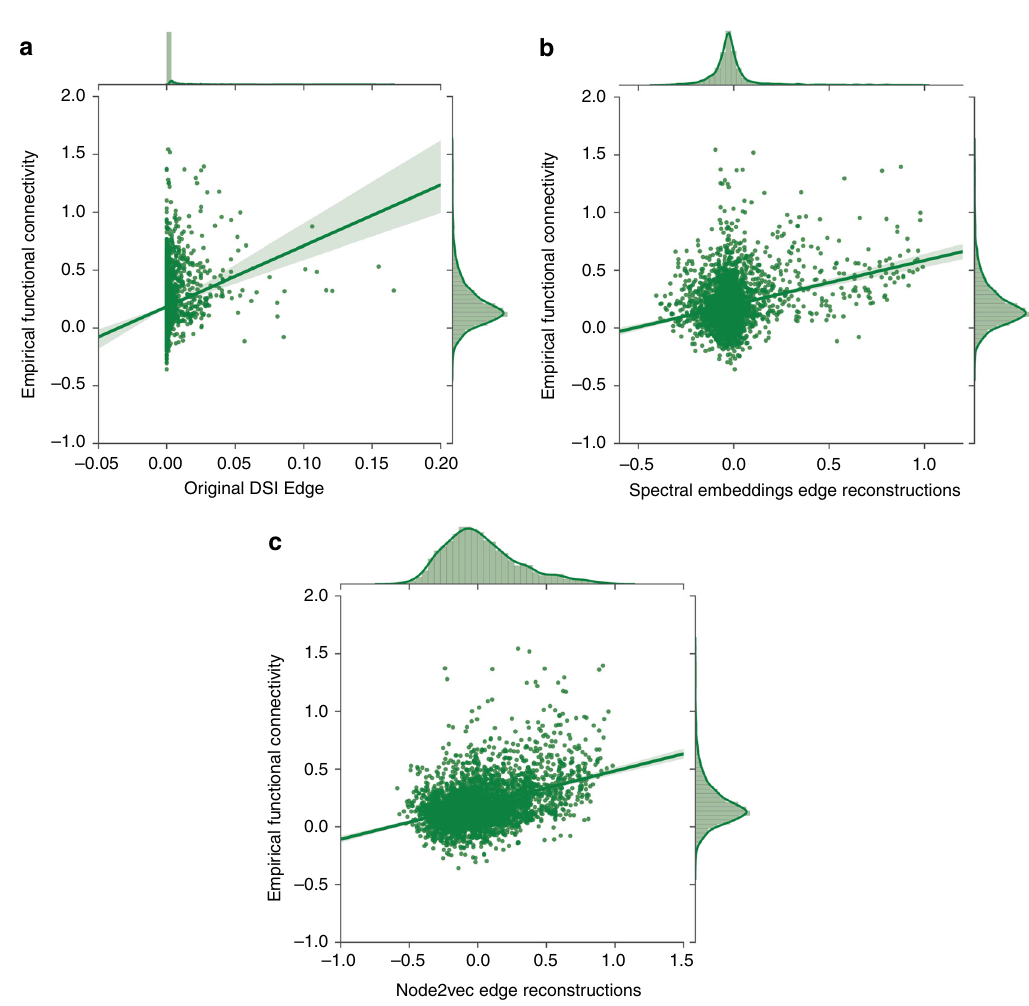
Fig. 4 Correspondence between resting state functional connectivity and structural connectivity. Correlation between resting state functional connectivity (after Fisher ’ s Z-transformation) and a original DSI connectivity matrix( r s = 0.311, p < 10 − 6 ), b spectral embeddings matrix reconstructions (r s = 0.13, p < 10 − 6 ) and c node2vec matrix reconstructions ( r s = 0.328, p < 10 − 6